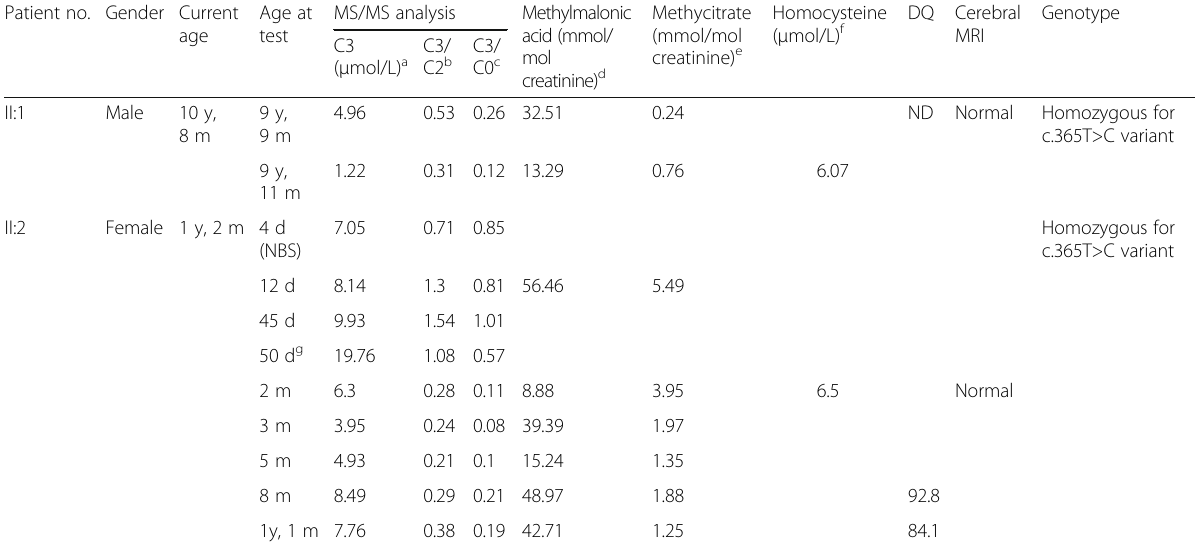
Table 1 Biochemical, clinical, and genetic characteristics of the siblings Patient no. Gender Current Age at MS/MS age test